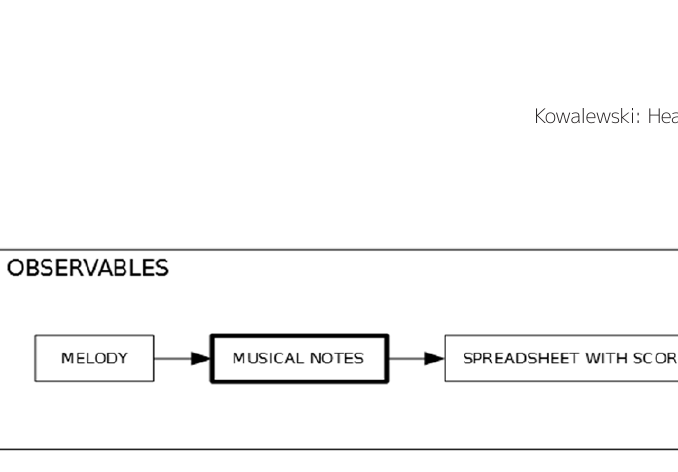
Figure 3: Contiguity relations in musical note for melody (author’s own